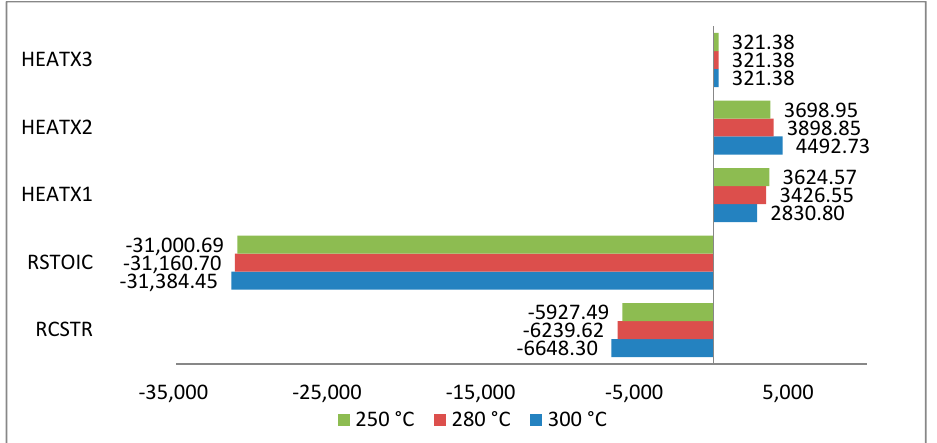
Figure 4. Heat duty of the key blocks in the process.